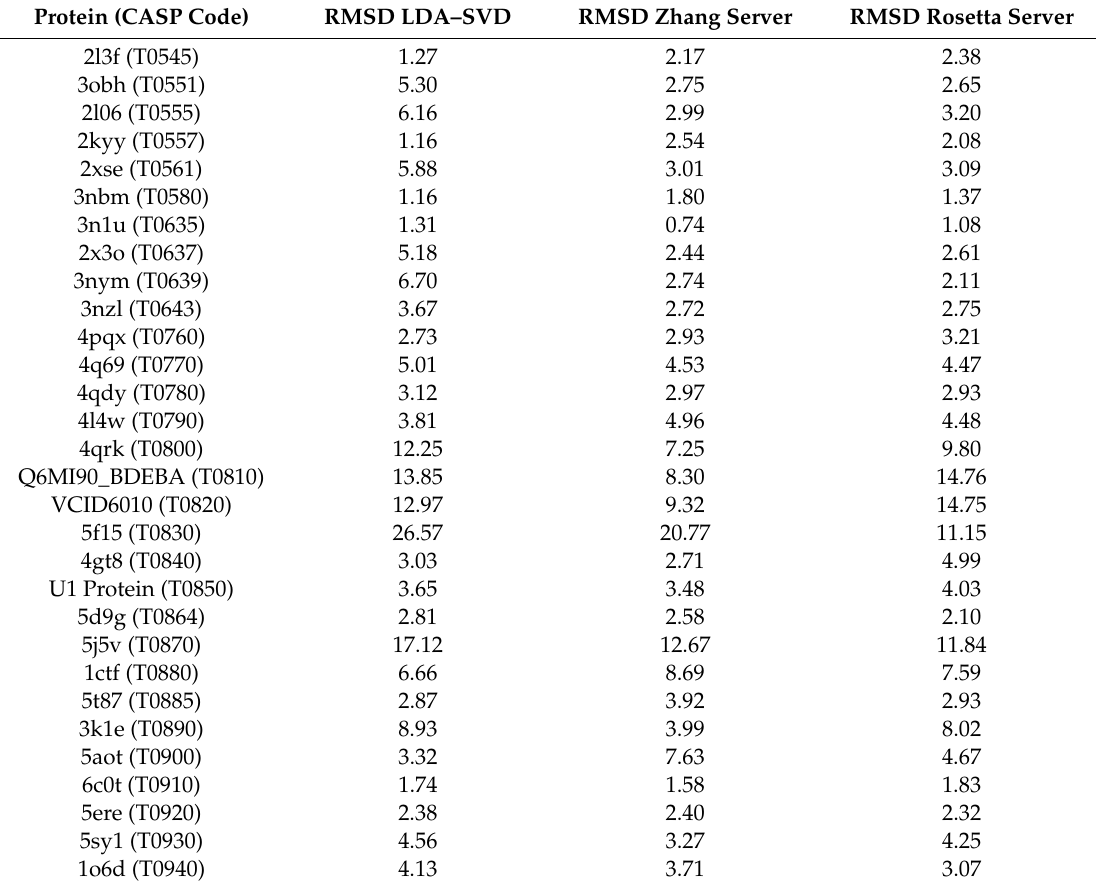
Table 3. RMSDs predicted structures via LDA–SVD and particle swarm optimization compared to Rosetta and Zhang